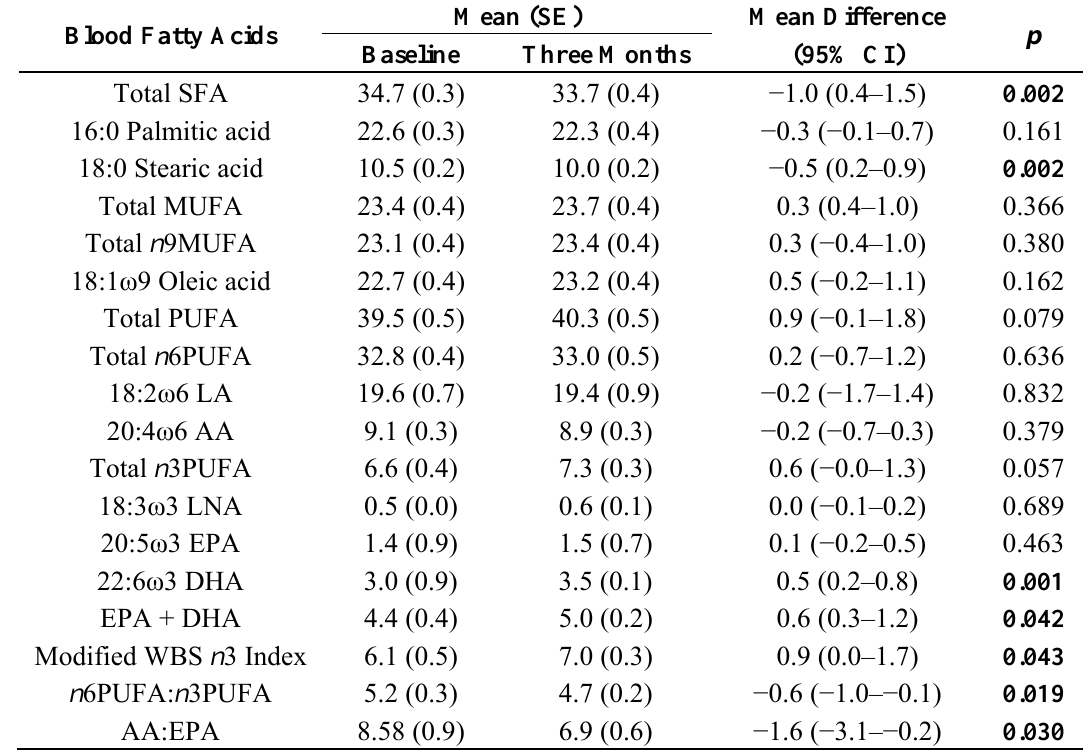
Table 3. Whole blood fatty acid profile expressed as mean percent, at baseline and three months. Blood Fatty